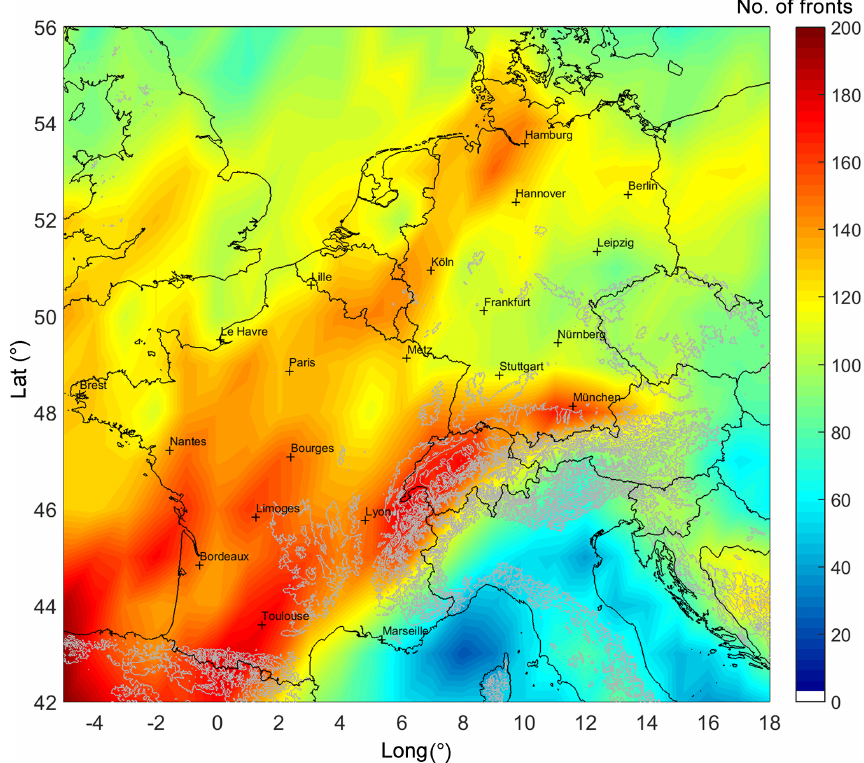
Figure 3. Number of synoptic-scale fronts per 1 ◦ × 1 ◦ area between 2005 and 2014 (SHY) based on the ERA-Interim reanalysis according to Schemm et al. (2015). Grey isolines represent the terrain (600, 1200, 1800, and 3600ma.s.l.). Please note that the cities in this figure are presented in their local names.